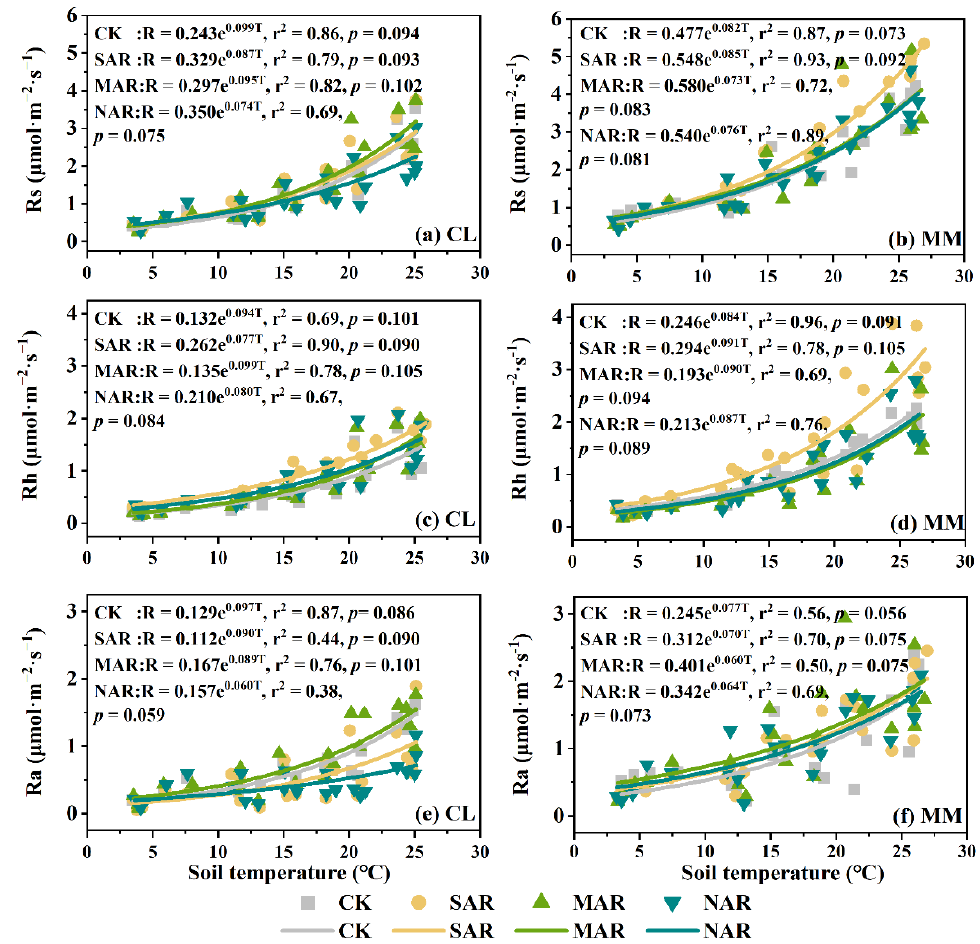
Figure 5. Relationship between Rs ( a , b ), Rh ( c , d ), Ra ( e , f ), and soil temperature under different types of acid rain in Cunninghamia lanceolata (Lamb.) Hook. (CL) and Michelia macclurei Dandy (MM) plantations.